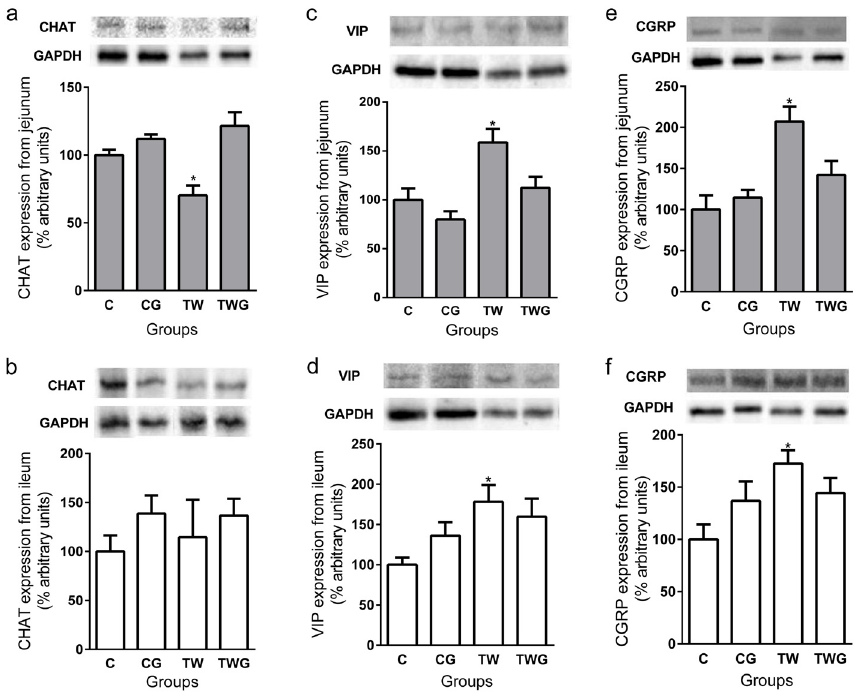
Fig 4. Effect of supplementation of L-glutamine and cachexia on proteins (CHAT, VIP and CGRP) expression from jejunal and ileal samples of each experimental group. Groups: control (C); control supplemented with 2% L-glutamine (CG); Walker-256 tumor (TW); and Walker-256 tumor supplemented with 2% L-glutamine (TWG). (a) Jejunum CHAT expression and representative bands (on the top). (b) Ileum CHAT expression and representative bands (on the top). (c) Jejunum VIP expression and representative bands (on the top). (d) Ileum VIP expression and representative bands (on the top). (e) Jejunum CGRP expression and representative bands (on the top). (f) Ileum CGRP expression and representative bands (on the top). Bars represent means ± SEM of samples from four animals. The data are presented as percentage arbitrary units (% of control) after normalization (GAPDH). * indicates significant difference ( p < 0.05) versus control group.